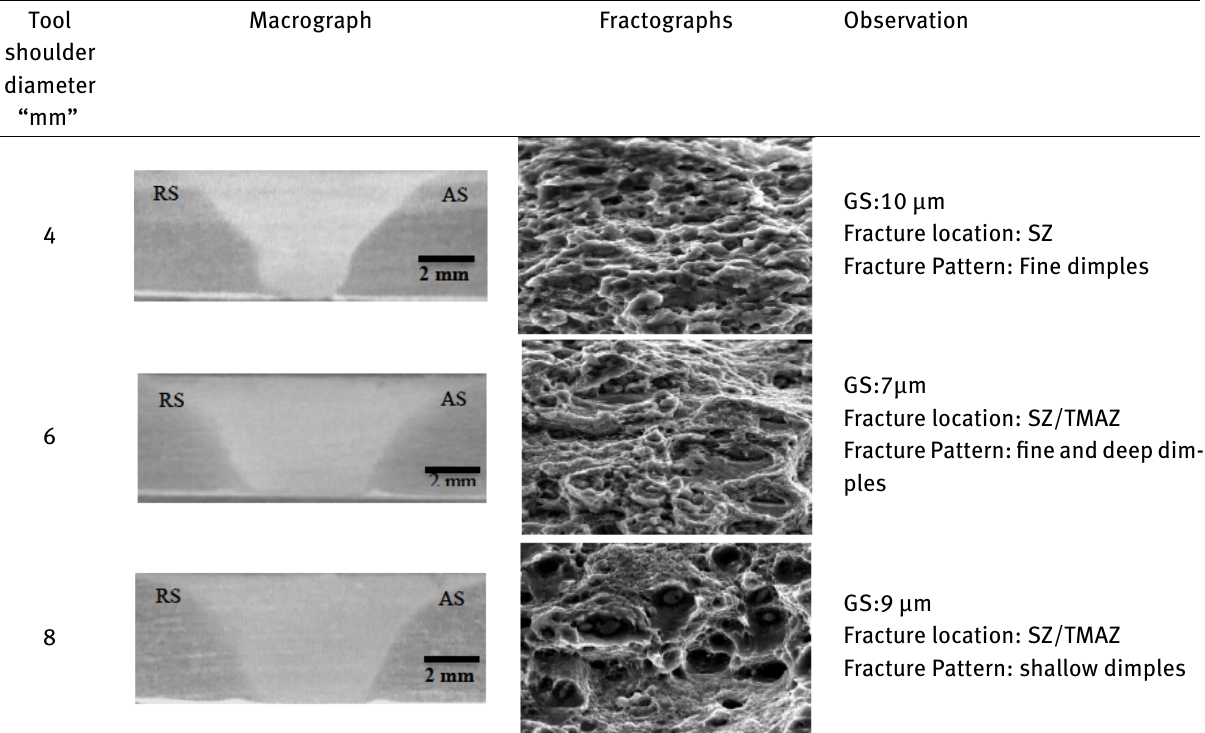
Table 7: Effect of shoulder diameter on macrograph and fracture